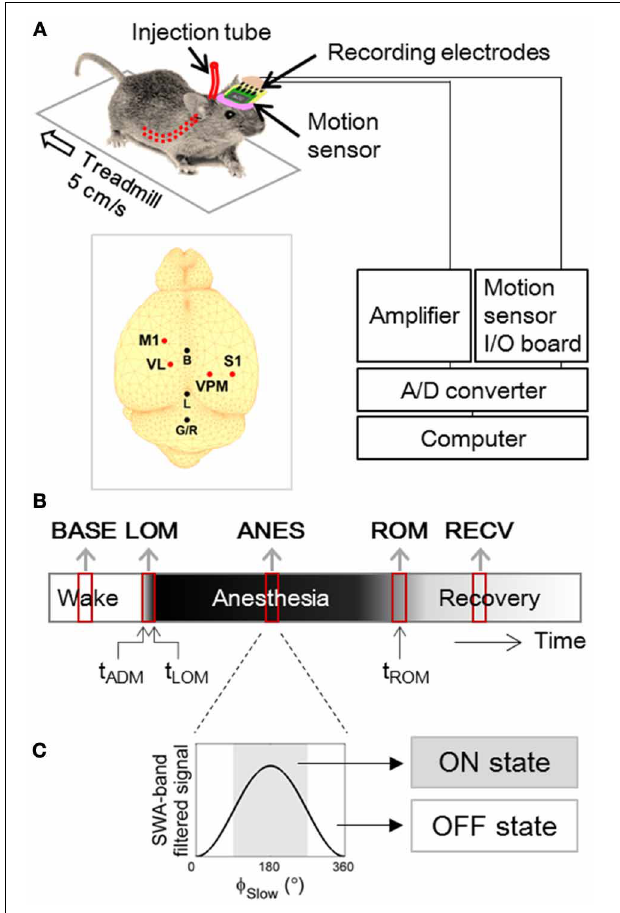
FIGURE 1 | Experimental Design. (A) Experimental setup for forced walking test (Hwang et al., 2010). Inset figure shows locations of screw and wire electrodes for EEG/LFP recordings. M1, primary motor cortex; S1, primary somatosensory cortex; VL, ventral lateral thalamic nucleus; VPM, ventral posteromedial thalamic nucleus; B, bregma; L, lambda; G/R, ground and reference. (B) Timeline of EEG and LFP recording. Two to three min of artifact-free steady periods were sampled from baseline (BASE), anesthesia (ANES), and motion-recovered (RECV) state, and transitional periods were sampled around the moment of loss of motion (LOM) and the moment of recovery of motion (ROM). (C) Anesthetic period was sub-classified based on the phase of slow wave ( φ Slow ) dominant during anesthesia, into ON state where 90 ◦ ≤ φ Slow < 270 ◦ and OFF state where φ Slow < 90 ◦ or ≥ 270 ◦ . φ φ Slow Slow was calculated by Hilbert transformation of EEG/LFP signal filtered between 0.5–4Hz (400th order zero-phase FIR band-pass